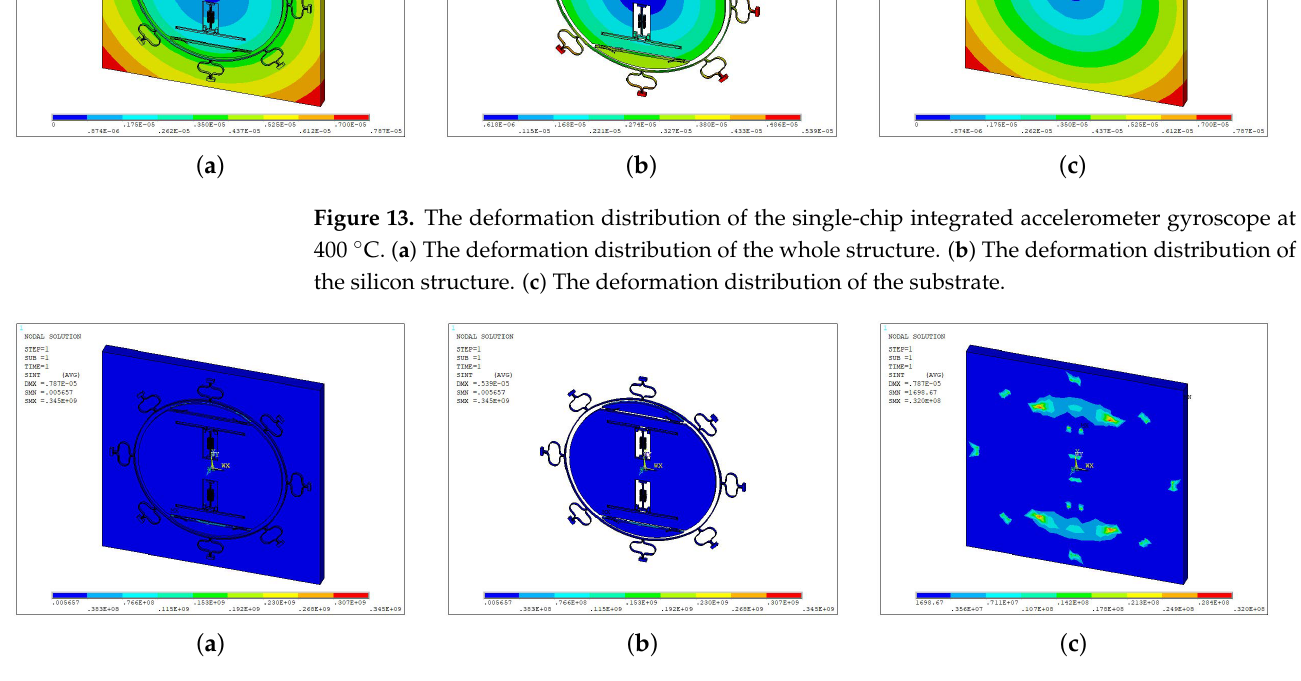
Figure 14. The stress distribution of the single-chip integrated accelerometer gyroscope at 400 ◦ C. ( a ) The stress distribution of the whole structure. ( b ) The stress distribution of the silicon structure. ( c ) The stress distribution of the